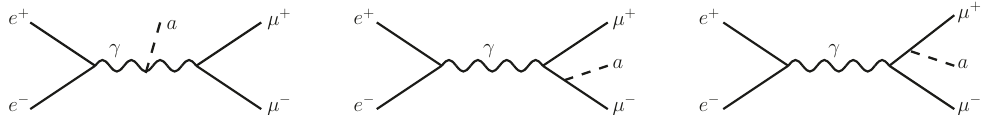
+ (cid:22) (cid:0) ! (cid:22) (cid:0) a